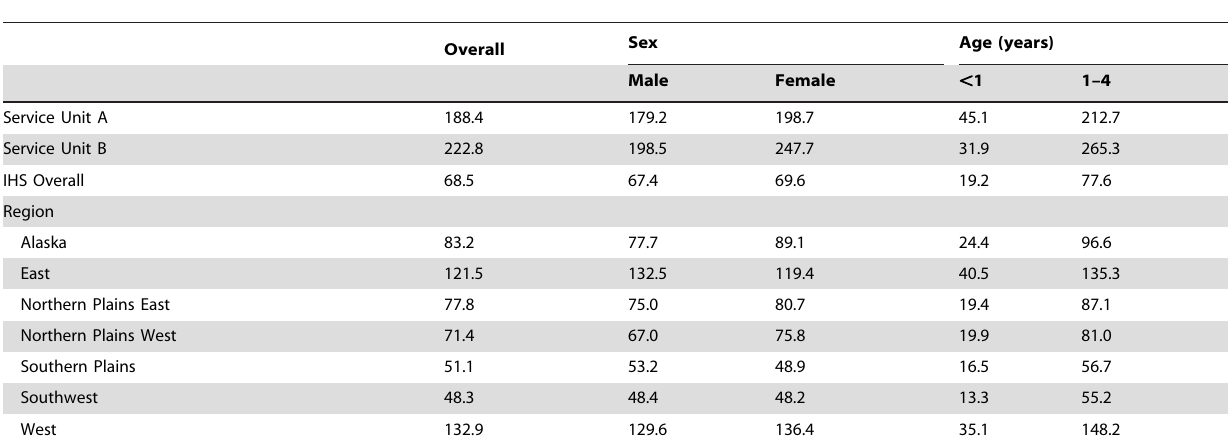
Table 1. Incidence rates a of molluscum contagiosum in American Indian children , 5 years of age, fiscal years 2001–2009.